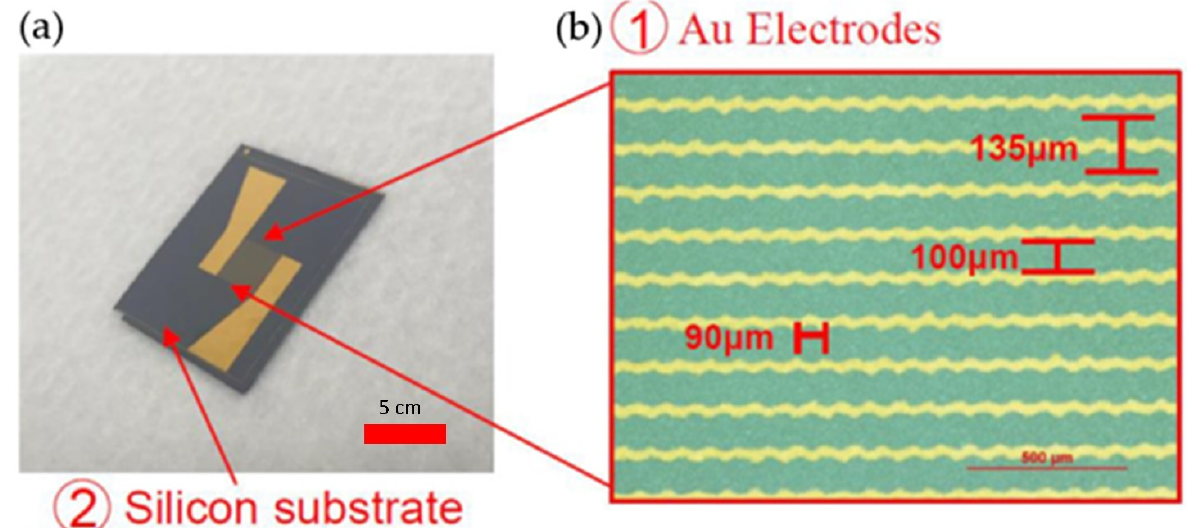
Figure 1. ( a ) Actual finished product of the biosensor chip. ( b ) Close view along with the dimensions of the electrodes.